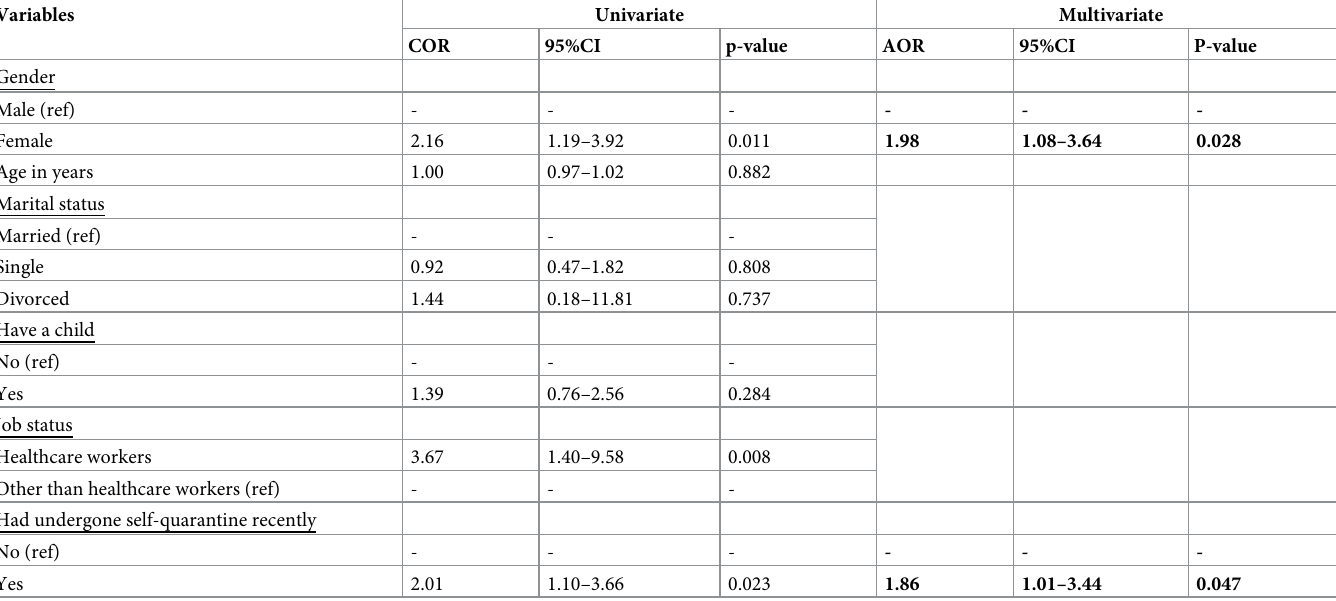
Table 6. Univariate and multivariate logistic regression analysis for